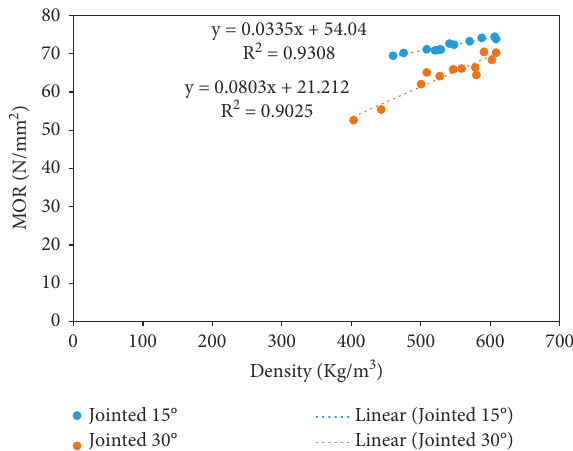
Figure 13: Bending strength as a function of density for jointing 15 ° and jointing 30 ° specimens.